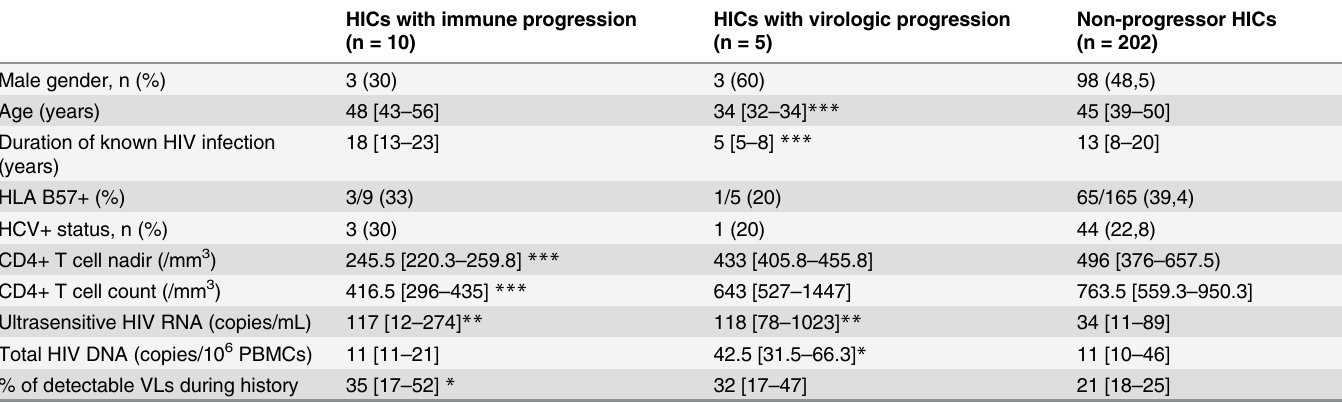
Table 1. Characteristics of the study population at enrollment into the cohort.